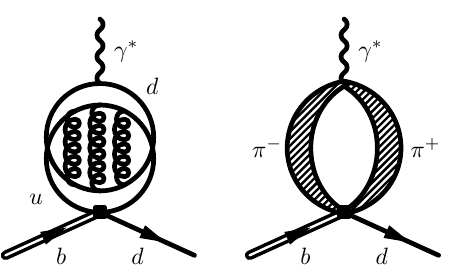
( (cid:11) 3 )-suppressed in perturbation theory, and s O